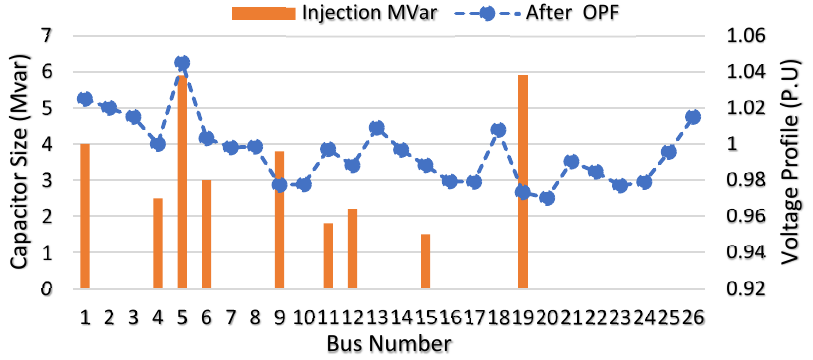
Figure 3. Distribution generation among different buses before and after the OPF .